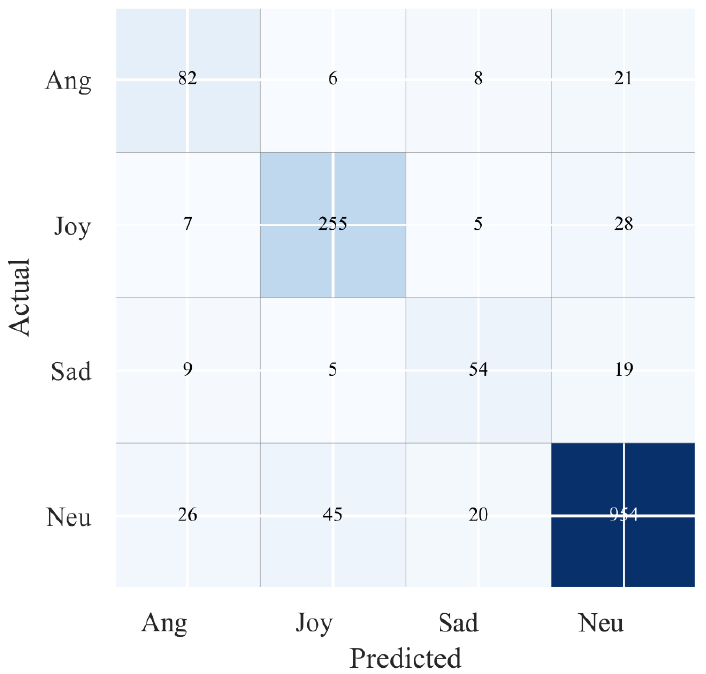
Figure 6. Confusion matrix of HiTransformer-s for the evaluation set of Friend.